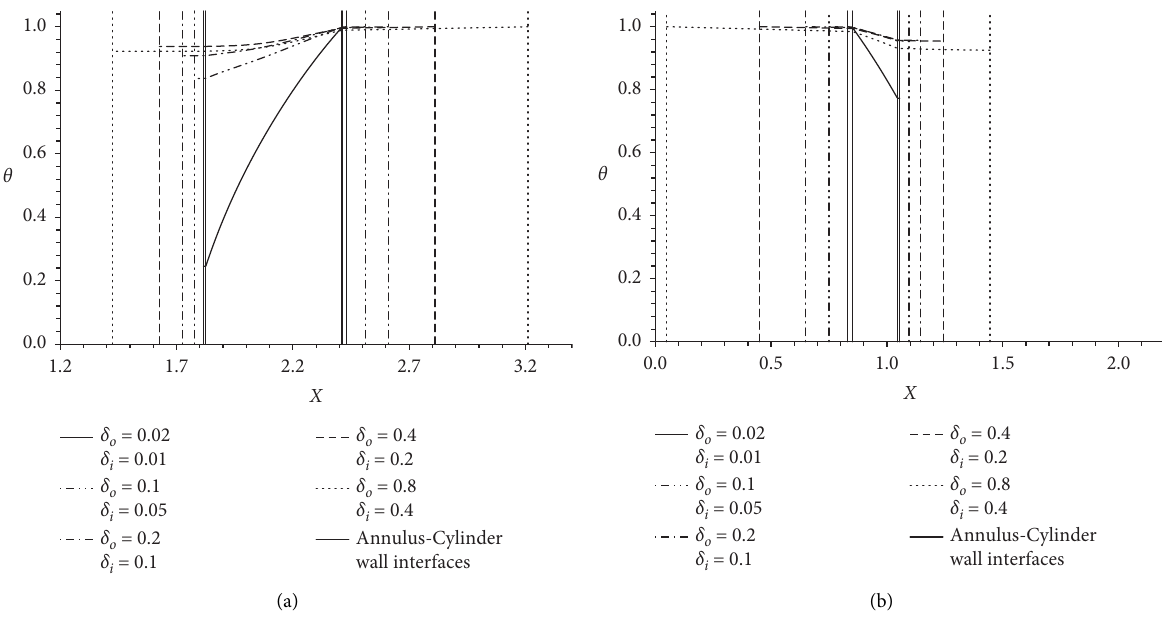
Figure 17: Temperature profile across the channel, at the (a) widest and (b) narrowest gaps, at an axial location of 8.363 × 10 − 3 for different values of δ i and δ o (case O), K r � 10, E � 0.5, χ 2 �